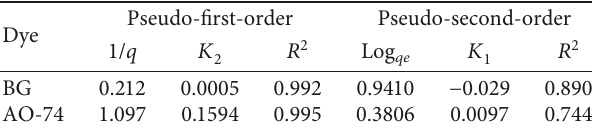
Table 7: Kinetic parameters for PR leaf powder sorption of dyes.